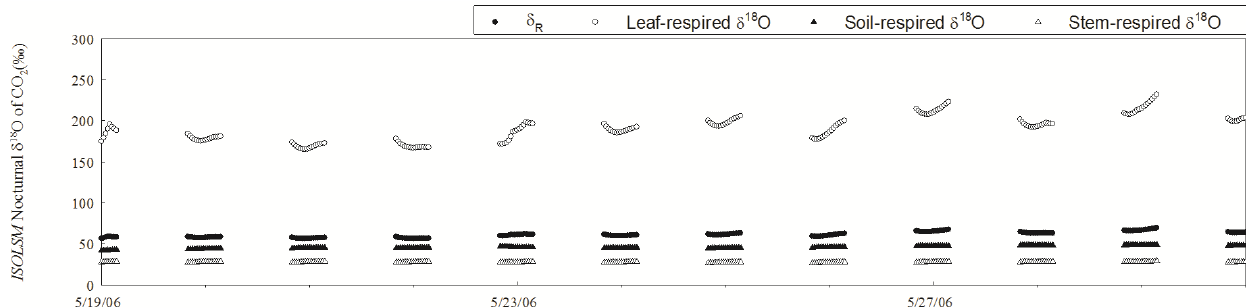
Fig. A6. ISOLSM simulation for nocturnal δ R (filled circle), δ 18 O of foliar-respired CO 2 (open circle), δ 18 O of soil-respired CO 2 (filled triangle) and δ 18 O of stem-respired CO 2 (open triangle).